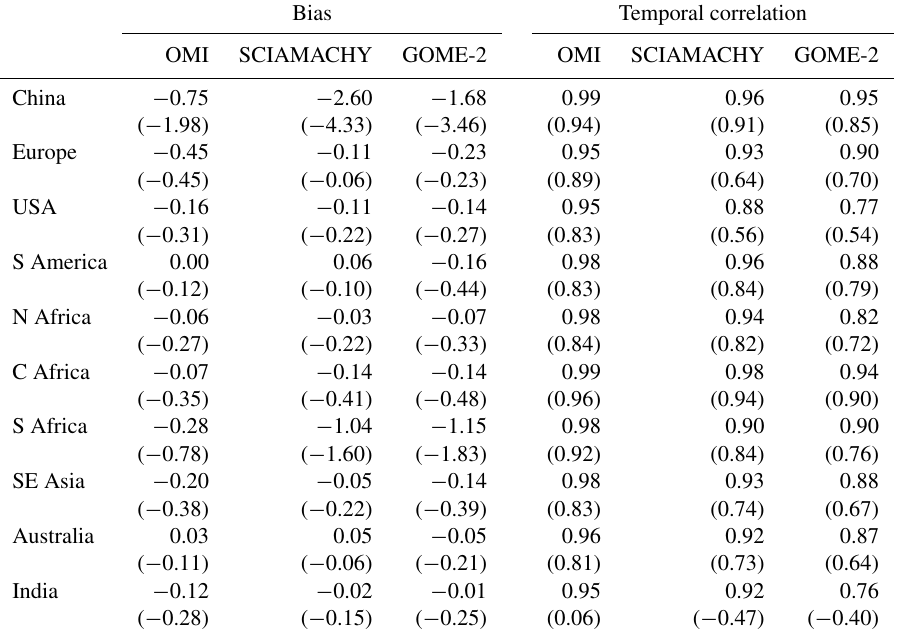
Table 2. The monthly mean bias and temporal correlation of regional mean tropospheric NO 2 columns: the data assimilation minus the satellite retrievals from OMI for the period 2005–2014, SCIAMACHY for the period 2005–2011, and GOME-2 for the period 2007–2014 in 10 15 moleccm − 2 . The results of the model simulation (without data assimilation) are also shown in brackets. Bias Temporal